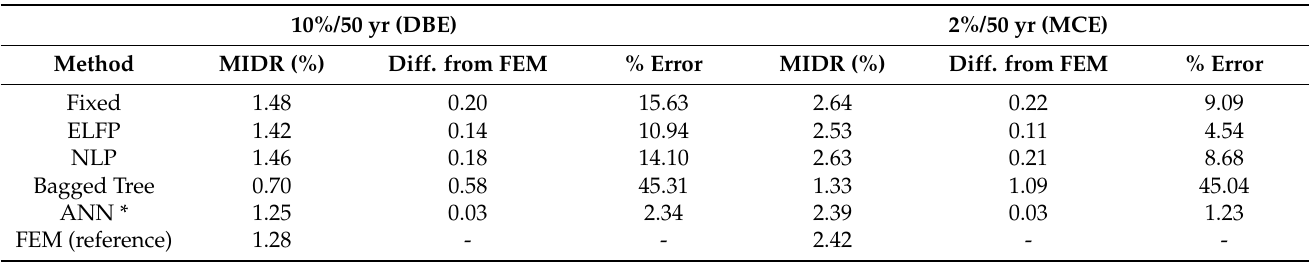
Table 6. Values of MIDR obtained from different techniques for the three-story mass irregularity structure.